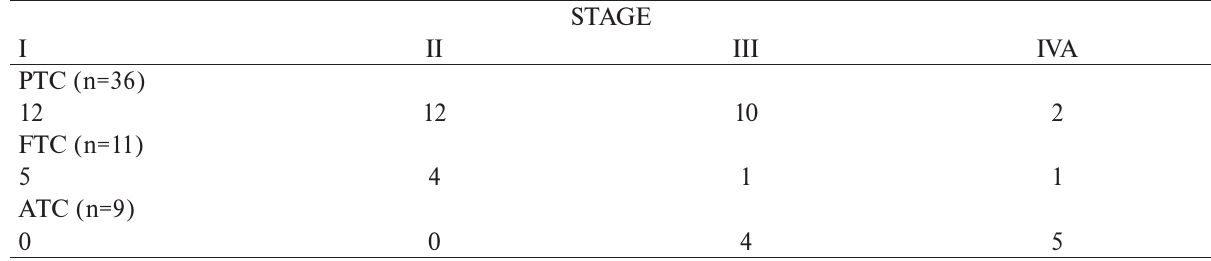
Table 2. Histopathological diagnosis and clinical staging of thyroid cancer patients recommended by the 2010 TNM system edition by the Union for International Cancer